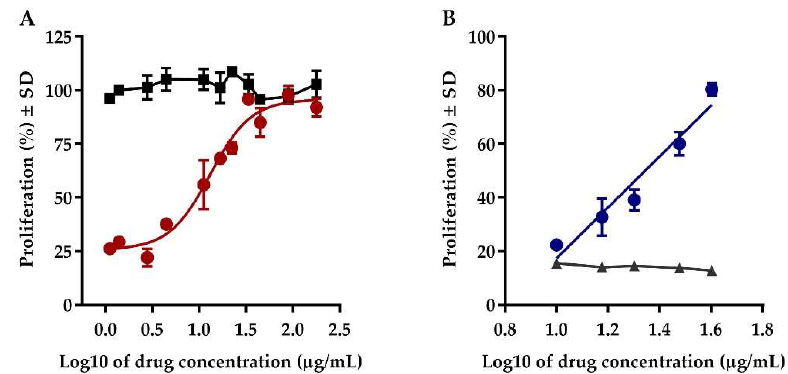
Figure 1. Effect of Transferon ® on the proliferation of Jurkat cells. ( A ) Comparison of the Transferon ® dose–response curve (1–180 µg/mL) using cells exposed (red circles) and not exposed to azathioprine (black squares). ( B ) Dose–response curve exhibiting a linear behavior in a concentration range from 2.5 to 40 µg/mL Transferon ® (blue circles) compared to the response of cells exposed to azathioprine and treated with a vehicle (grey triangles).